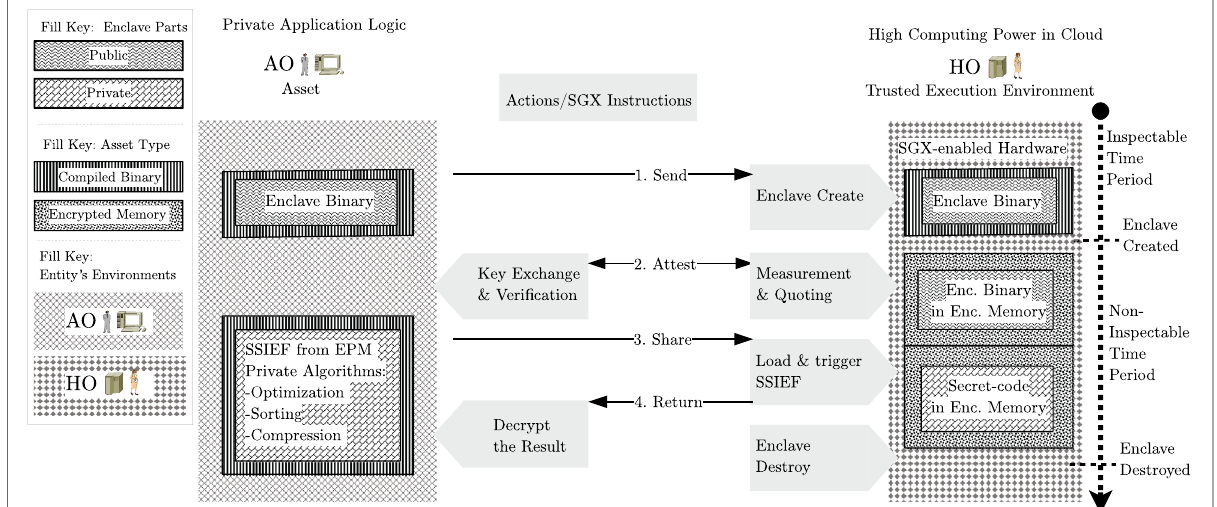
Fig. 9 Secret-Code Execution (SCE) Computational Power. The AO creates a session with the enclave binary, and shares the SSIEF. The SSIEF is extracted into the enclave memory at